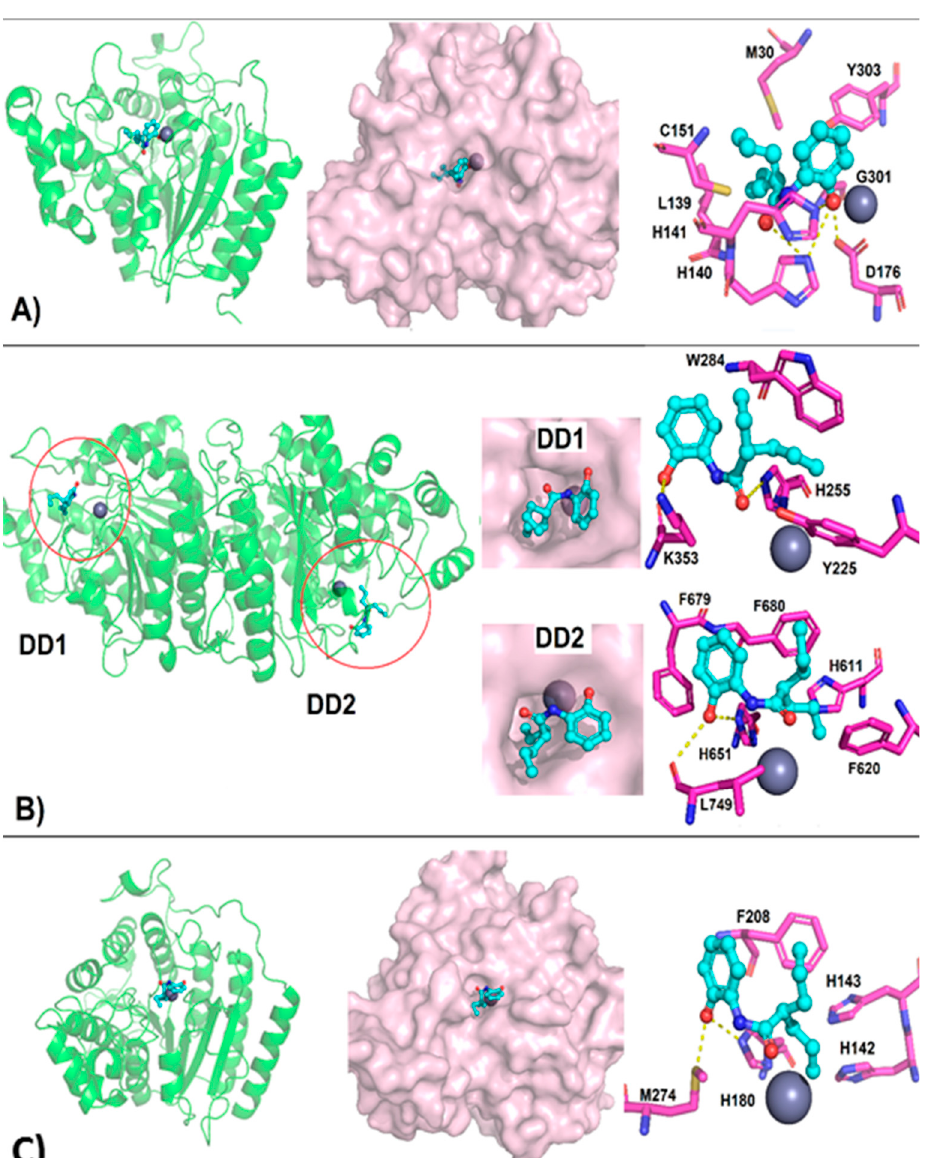
Figure 1. Molecular docking of HO-AAVPA with different HDAC isoforms. ( A ) HDAC1, ( B ) HDAC6, and ( C ) HDAC8. On the left side of the panel, the green ribbon represents the HDAC interacting with HO-AAVPA depicted as cyan ball and stick; in the center of the panel, the pink surface represents HDAC, and the ligand is shown as cyan ball and stick. On the right side, the HDAC residues that interact with HO-AAVPA are depicted with a gray ball and stick representation. Zn +2 is depicted as a gray sphere, and on the right side, the map of the interactions between HDACs and the ligands are depicted and explained in the text (Figure built with PyMOL v.099 and Discovery Studio v 16.1).